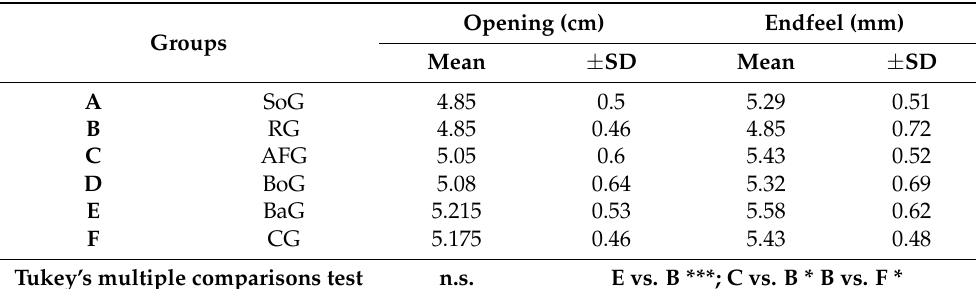
Table 9. Mean values and ± standard deviation ( ± SD) of opening and endfeel measured in the Basketball group (BaG), Soccer group (SoG), American Football group (AFG), Boxing group (BoG), Rugby group (RG) and Control group (CG). Ordinary Anova and Tukey’s multiple comparisons tests were performed among the groups